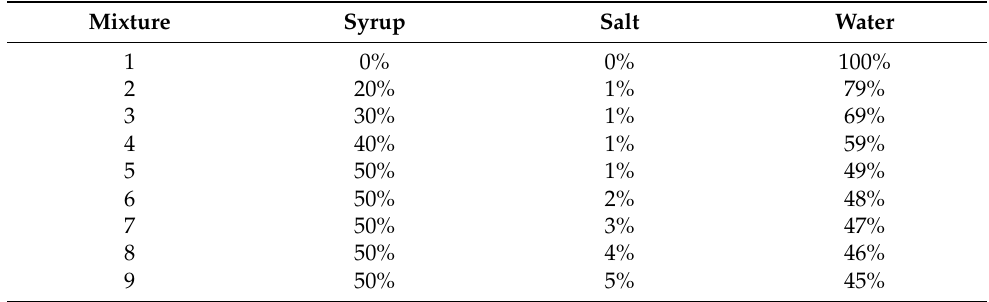
Table 5. The concentrations of syrup, salt, and water in nine experimental mixtures of equivalent